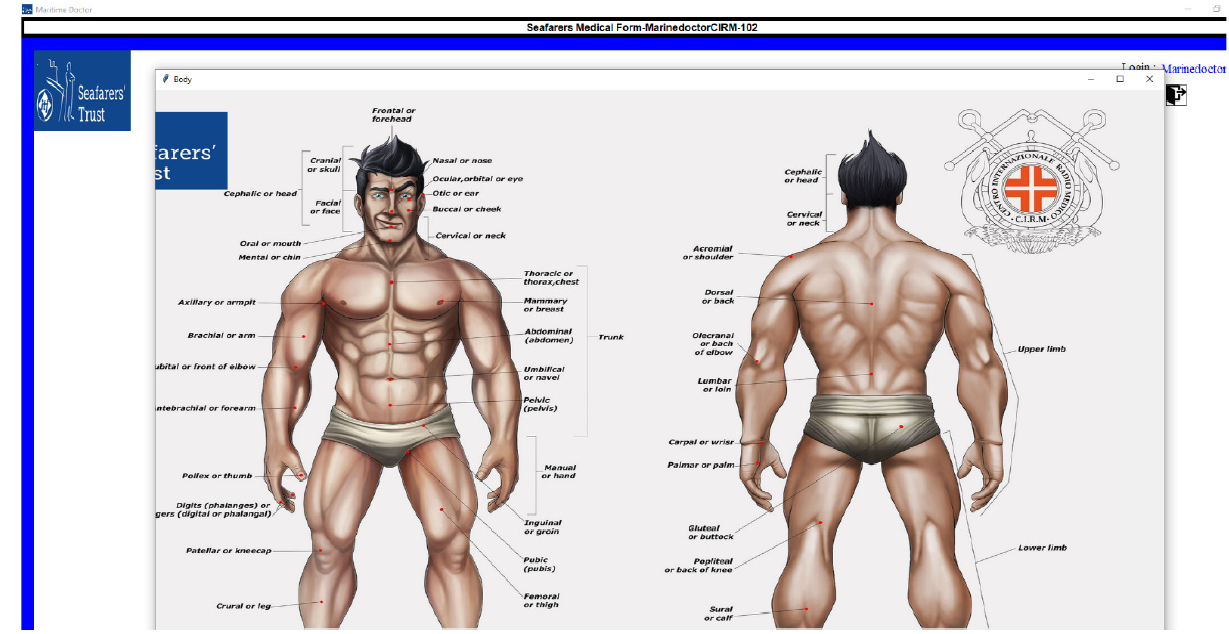
Figure 6. Representation of anatomical terminology.